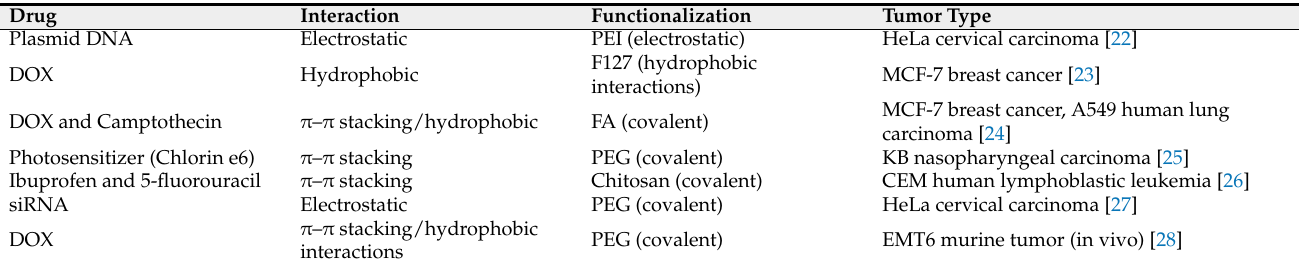
Table 1. Drug molecules loaded onto graphene.